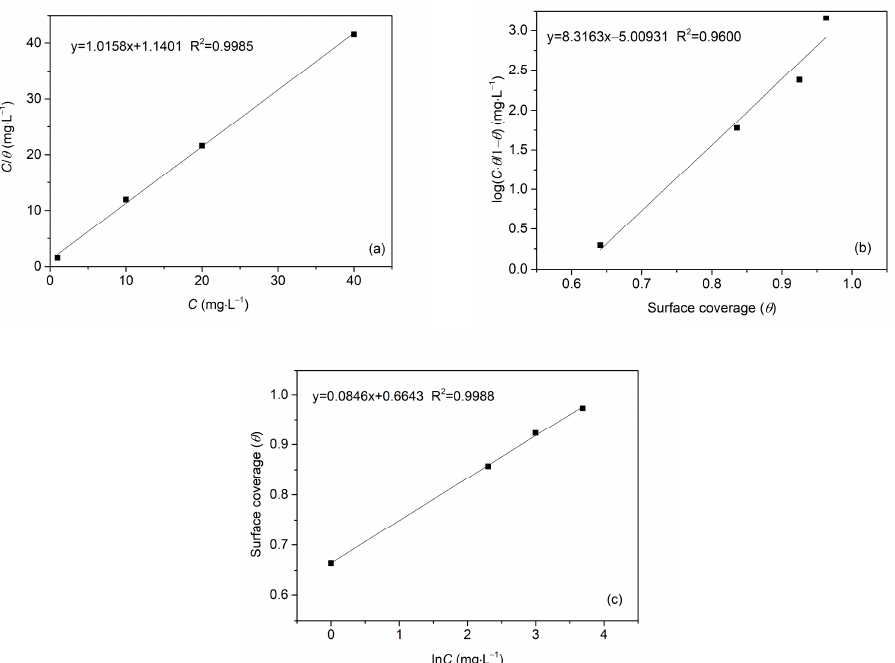
Figure 7. Different adsorption isotherm plots for the adsorption of TSCA on the surface of carbon steel in 1 M HCl at 298 K from potentiodynamic polarization results: ( a ) Langmuir’s isotherm, ( b ) Frumkin’s isotherm, ( c ) Temkin’s isotherm.